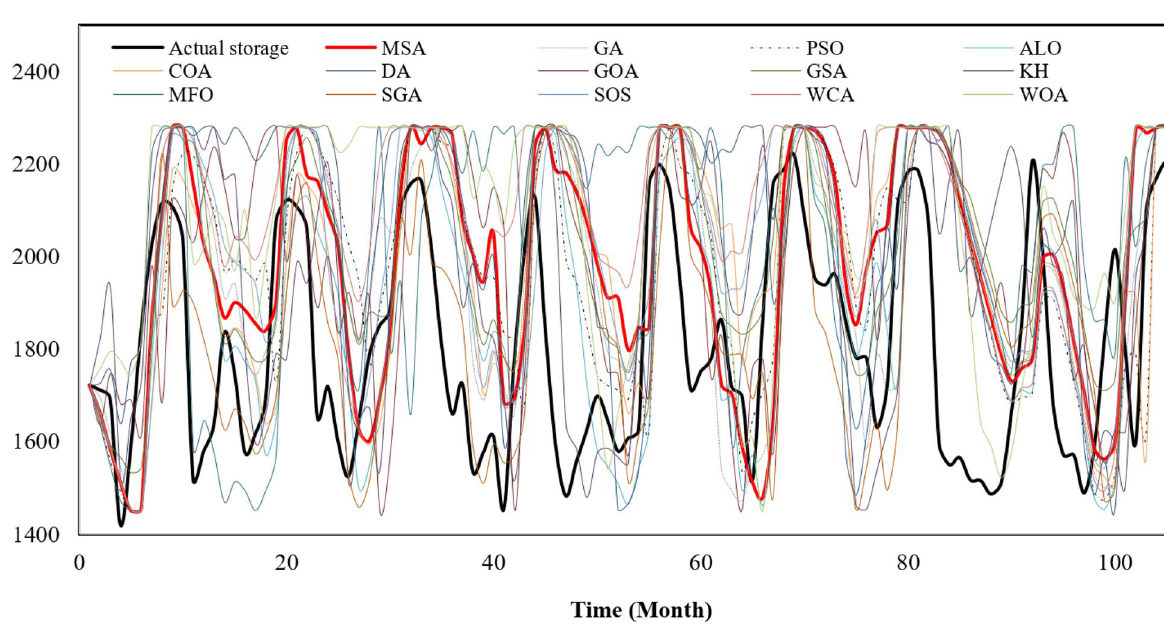
Figure 5. The actual storage volume of Karun-4 hydropower reservoir during operational period vs. the predicted values by the